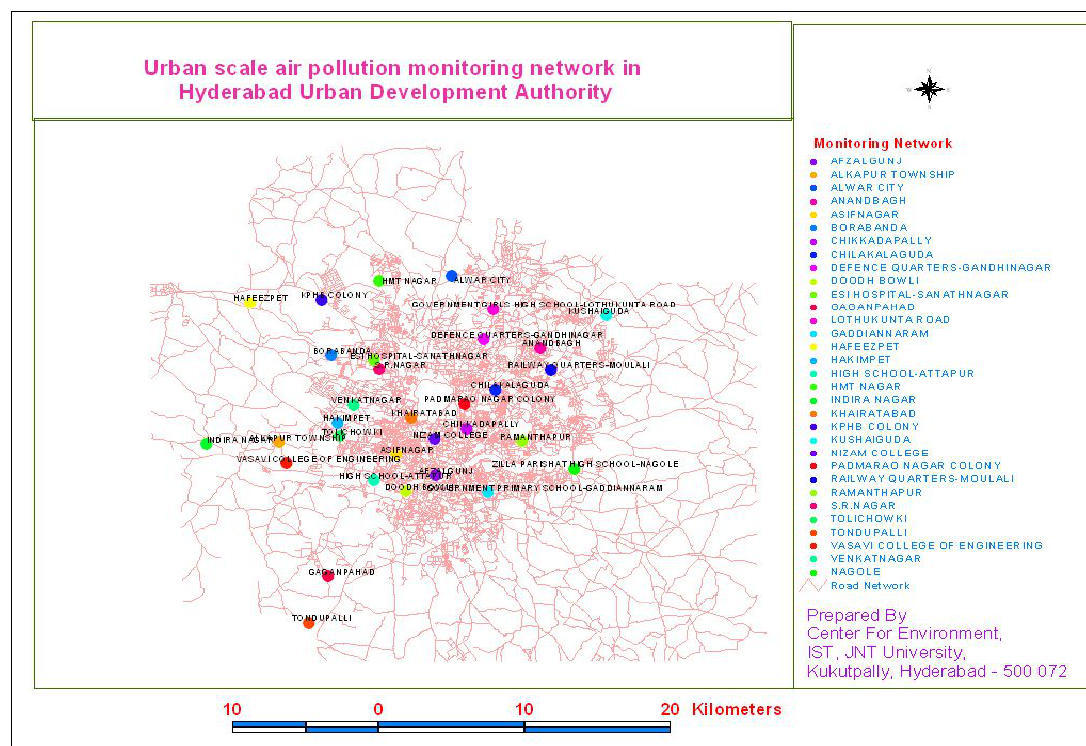
Figure 6: Urban scale air pollution monitoring network in Hyderabad